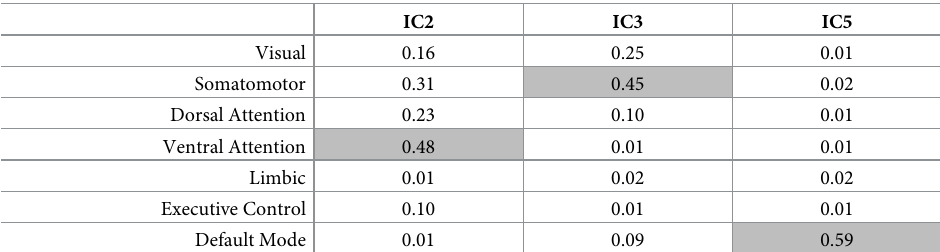
Table 3. Table of correlations of the whole-brain FC maps for each IC with known resting-state